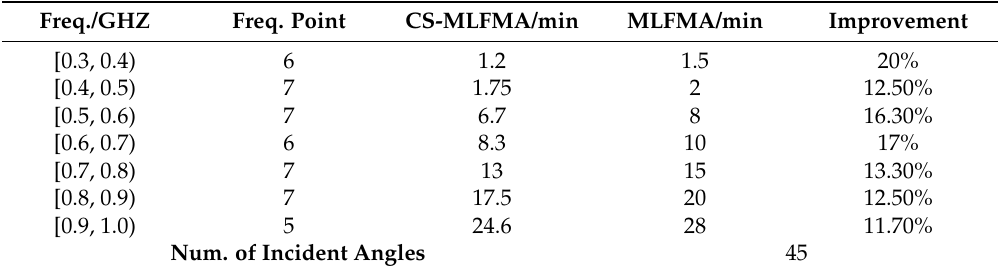
Table 4. Computation time for airplane